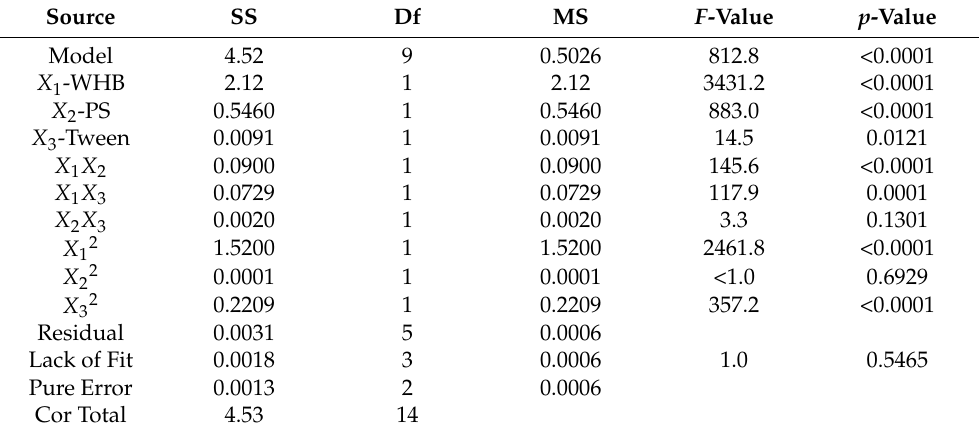
Table 4. Statistical analysis of the BBD